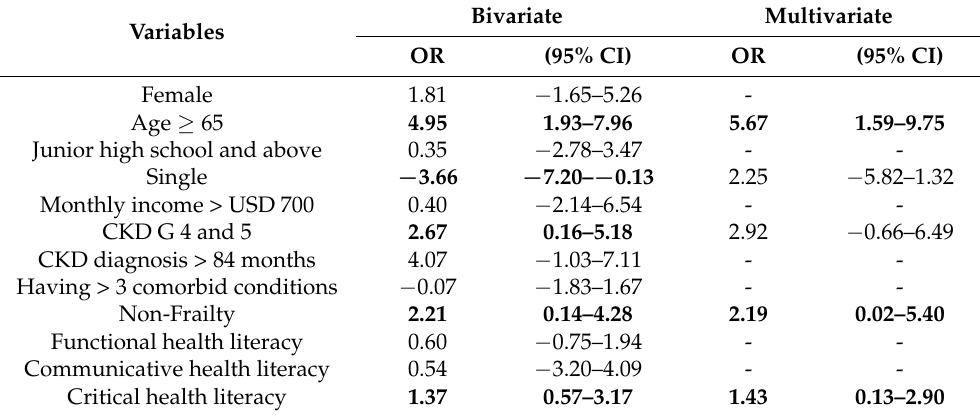
Table 3. Multiple linear regressions of